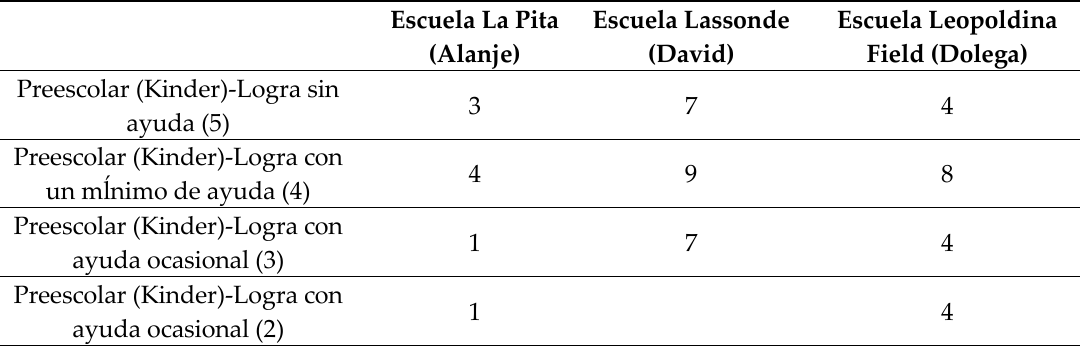
Table 3. Data of number of kindergarten students by scale of